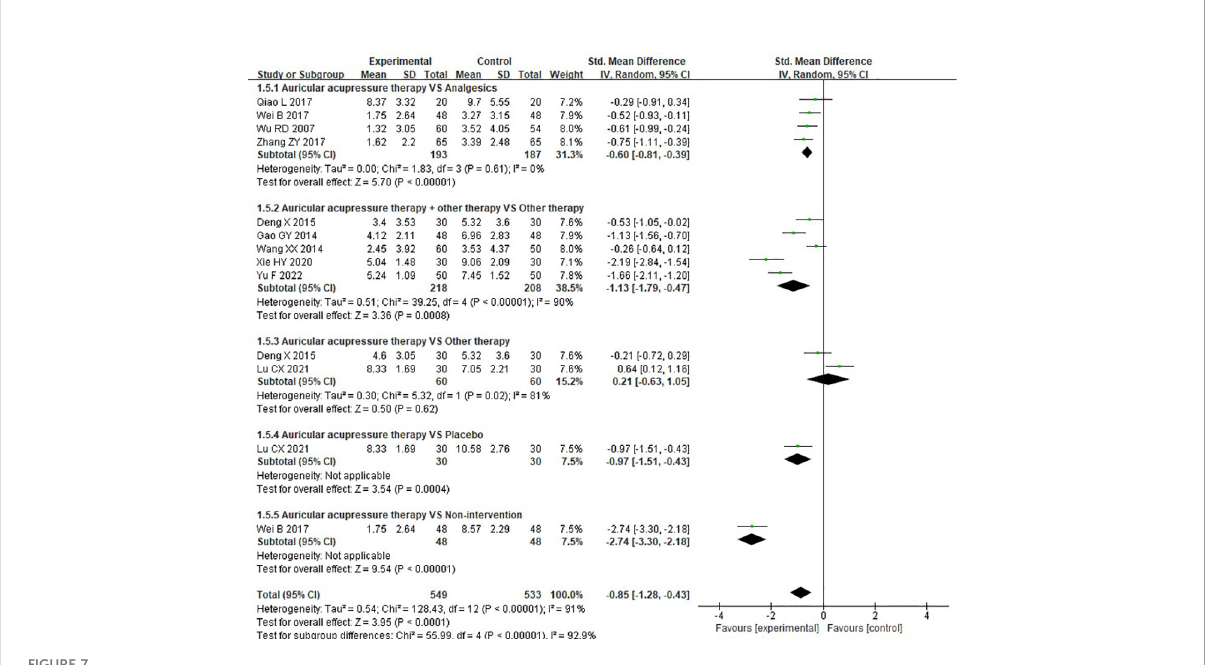
FIGURE 7 Meta-analysis and forest plot for symptom